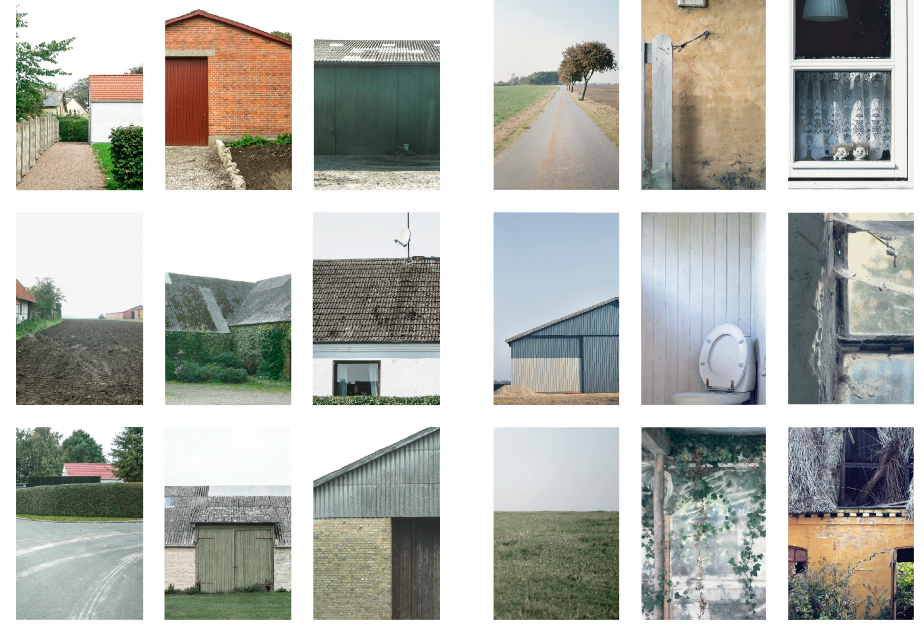
Figure 4. Two photographic student entries aiming at capturing the atmosphere of the village.